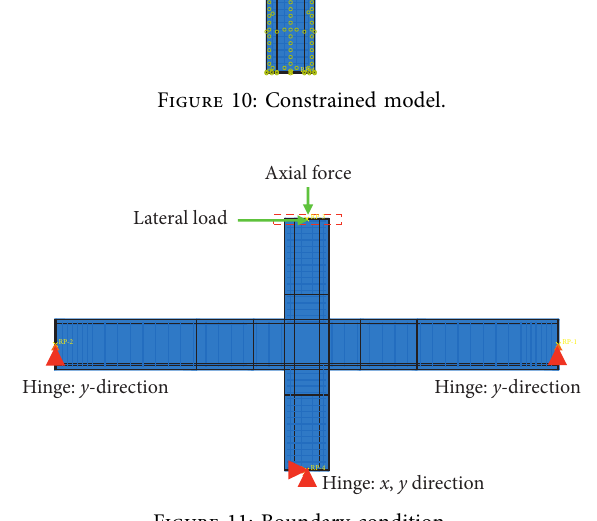
Figure 11: Boundary condition.